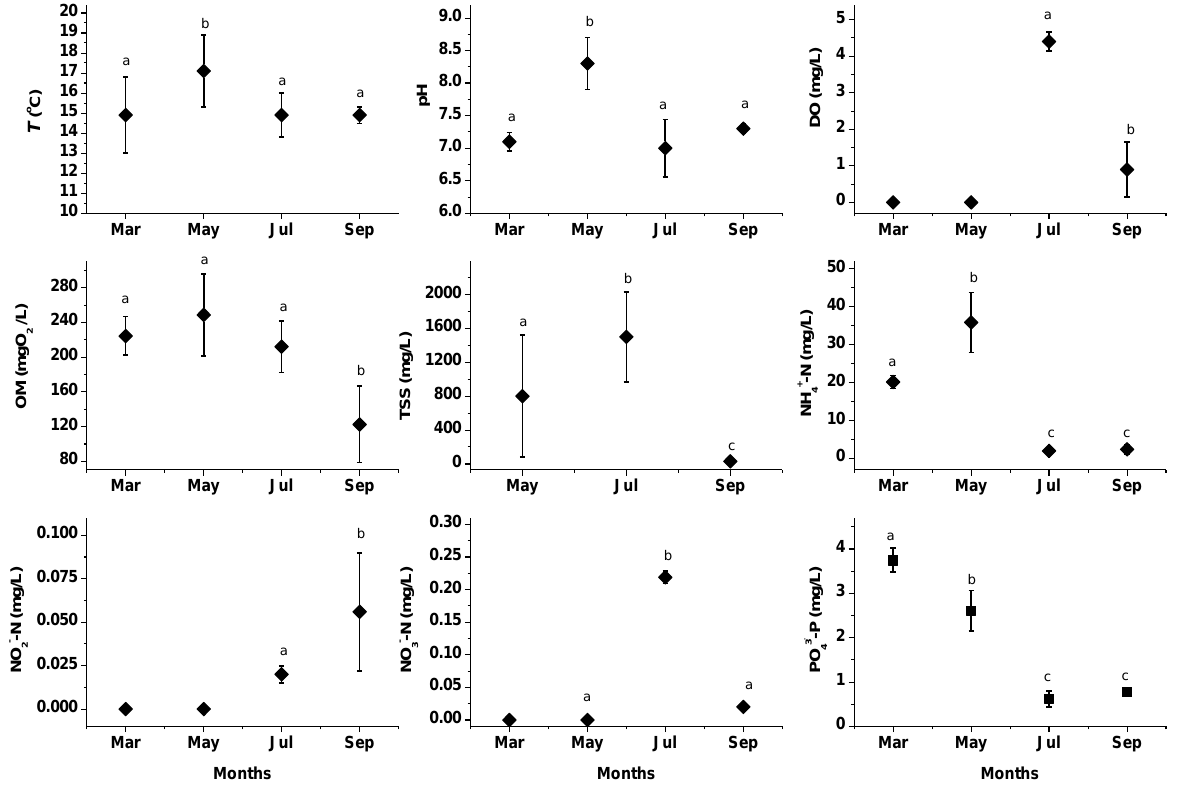
Figure 2. Physical and chemical parameters in the tributary. The Standard deviation (SD) represents the dispersion among scheduled samplings; dissimilar lowercase letters on the SD bars indicate significant differences in Tukey multiple comparison or Student t